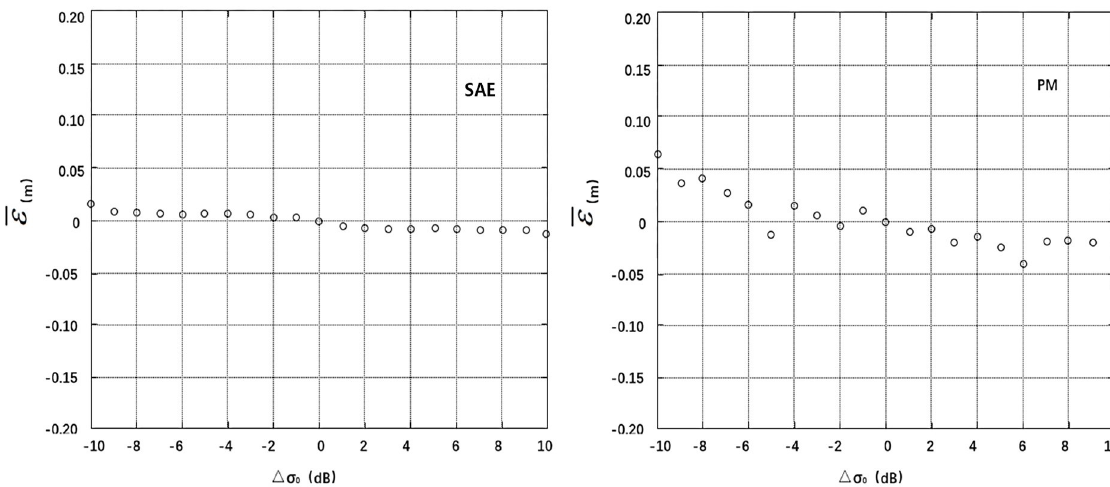
Fig 6. Distributions of mean residuals � ε according to Δ σ 0